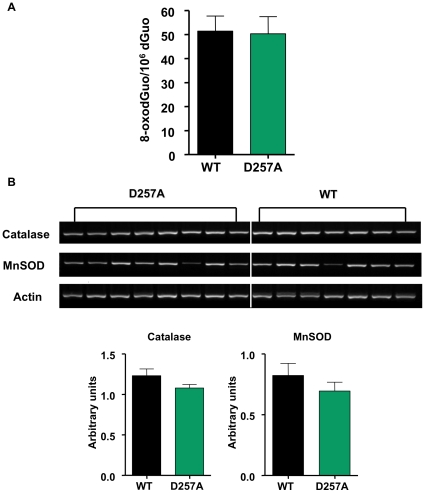
Mitochondrial DNA oxidation levels and antioxidant enzyme mRNA expression remain unaltered in D257A skeletal muscle.(A) We examined a marker of ROS-induced oxidative damage to DNA by assessing the levels of 8-oxodGuo in skeletal muscle mtDNA of 11-mo old WT and D257A mice (n = 11 per group), using HPLC with electrochemical detection. No statistically significant differences were detected. Mean values ±SEM are shown. (B) We measured Catalase and MnSOD mRNA expression in skeletal muscle extracts from 11-mo old WT (n = 7) and D257A (n = 8) mice by RT-PCR. Arbitrary units represent specific mRNA densitometry values normalized to actin mRNA densitometry values. No statistically significant differences were detected. Mean values ±SEM are shown.